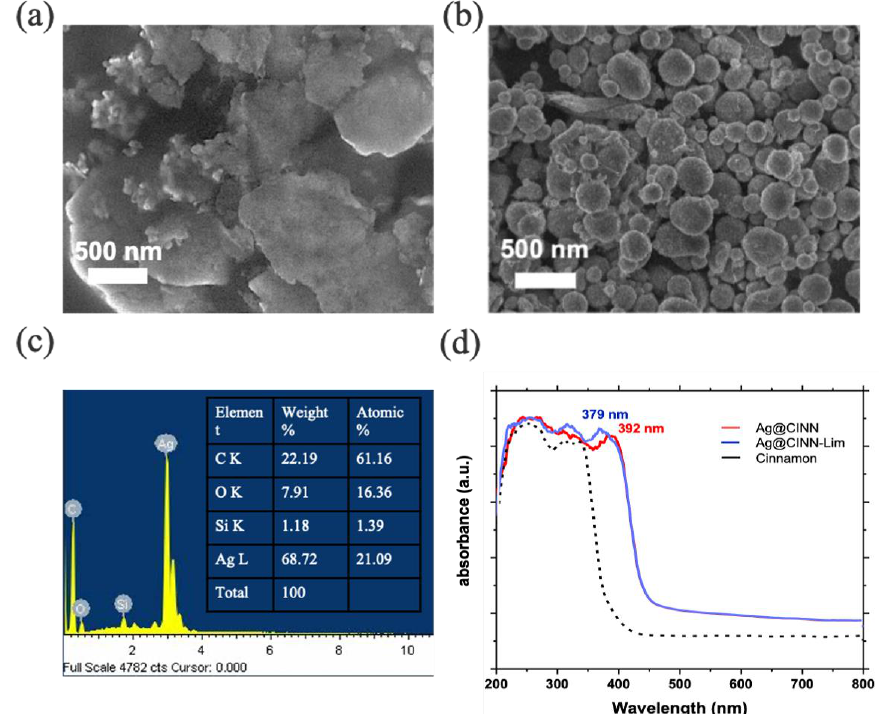
Figure 2. ( a , b ) SEM image of Ag@CINN and Ag@CINN-Lim nanoparticles. ( c ) The EXD